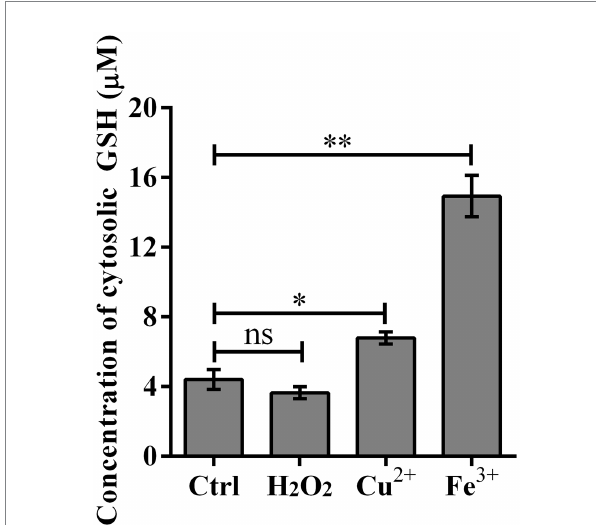
FIGURE 3 Cytosolic GSH concentration was significantly improved upon copper and iron treatment. Wild type strain Lm850658 was treated with BHI containing 10 mM hydrogen peroxide, 5 mM copper or 10 mM iron for 3 h and then bacteria were collected and lysed with lysozyme for 30 min. The concentrations of GSH were measured with commercial kit supplied by Beyotime Biotechnology as manufacturer’s instruction. The experiments were conducted for triplicate and data were expressed as mean ± SD. ns, no significance; *, p < 0.05; **, p < 0.01.